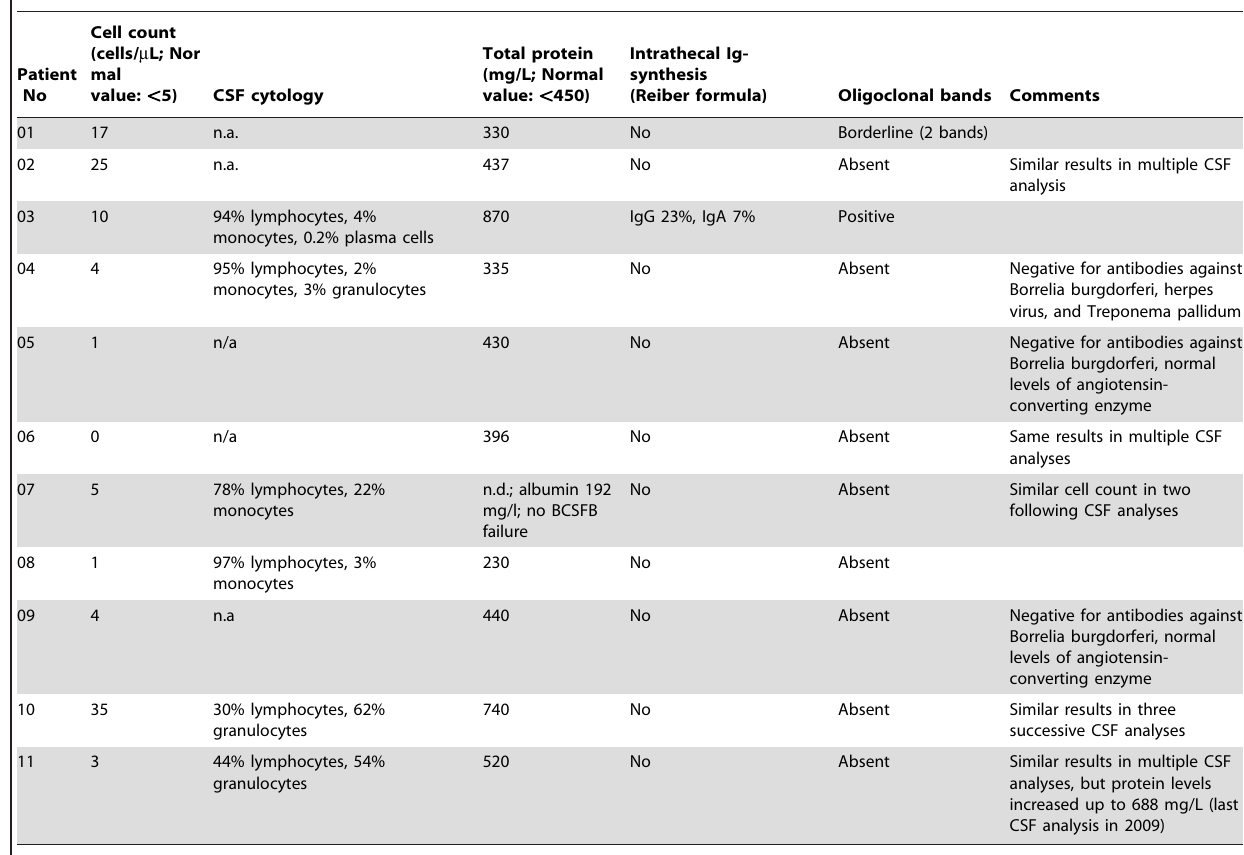
Table 2. CSF results of first diagnostic spinal tap.